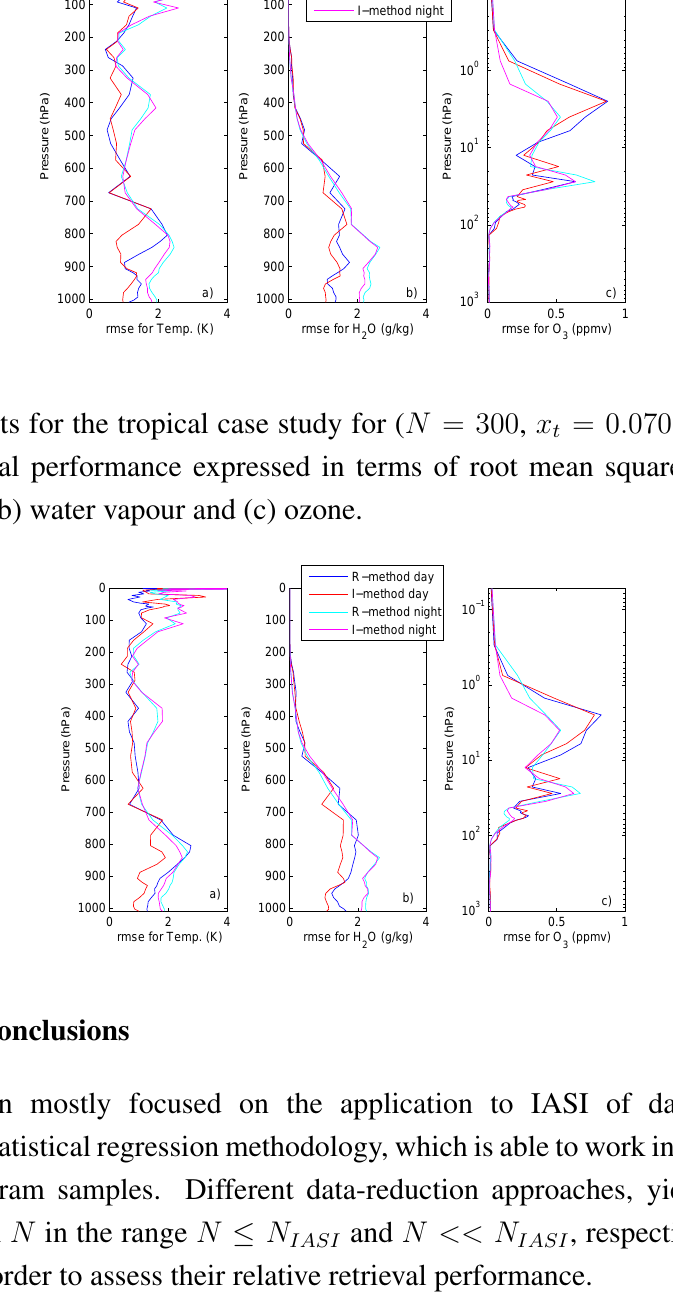
Figure 14. Results for the tropical case study for ( N = 3385 , x shows the retrieval performance expressed in terms of root mean square error (rmse) for (a) temperature, (b) water vapour and (c) ozone.